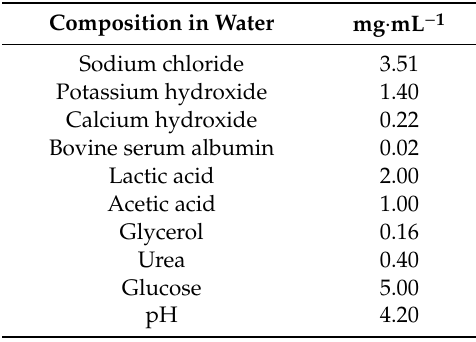
Table 4. Simulated vaginal fluid (SVF)